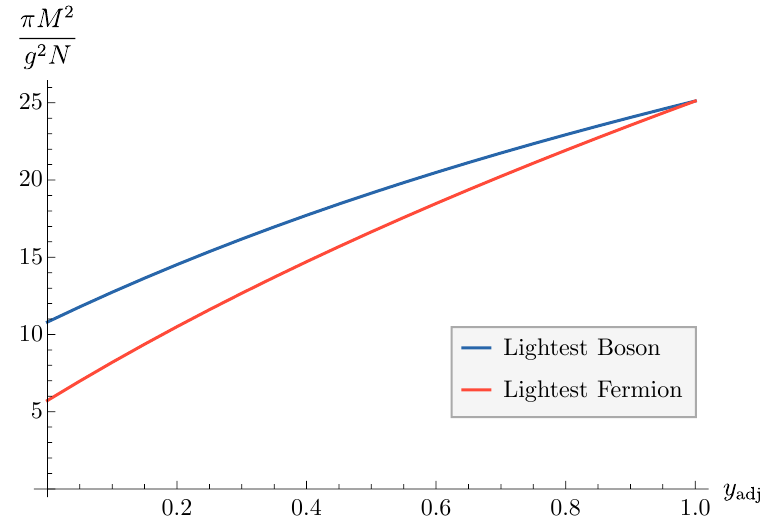
Figure 3 . The lightest fermion and boson states in the SU(2) theory as a function of the adjoint mass parameter y adj . These states become degenerate at y adj = 1 , a consequence of the emergent supersymmetry at this value.